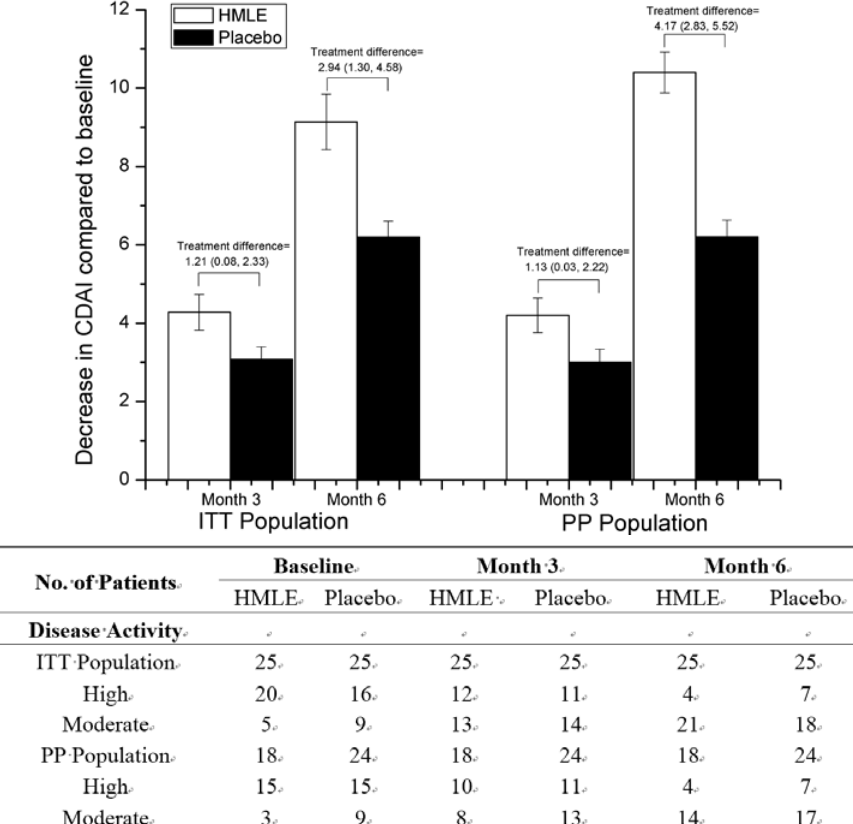
Figure 3. Changes over time in the Clinical Disease Activity Index (CDAI), and number of patients classified in High or Moderate severity of disease activity based on CDAI. Error bars represent